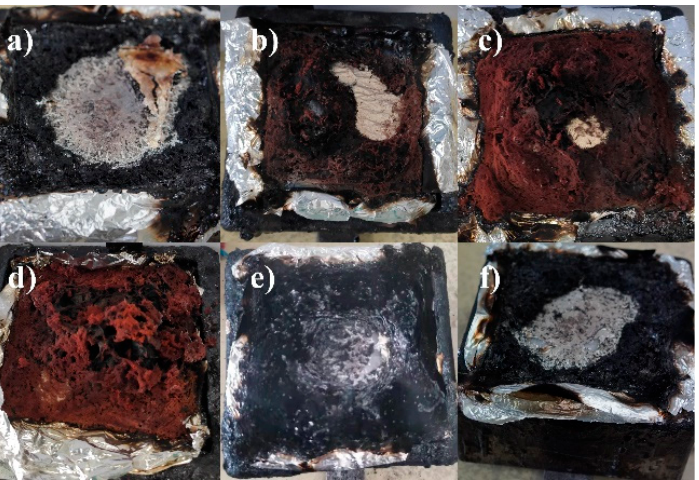
Figure 5. Digital photos of char residue of ( a ) PET, ( b ) 0.2MIL − PET, ( c ) 0.6MIL − PET, ( d ) 1.0MIL − PET, ( e ) P − PET, ( f ) 0.6MIL − P − PET.